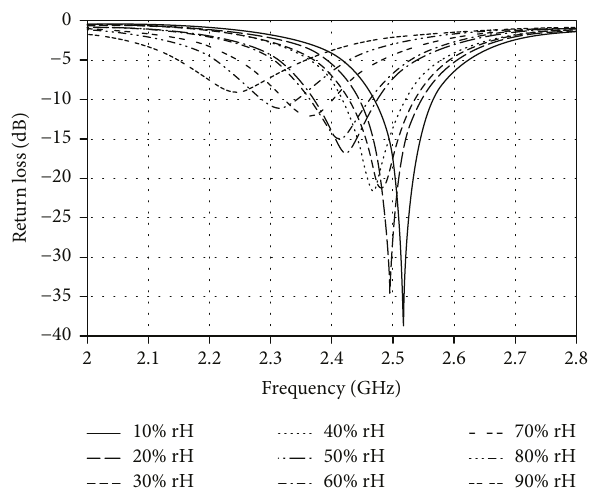
Figure 12: The e ff ect of relative humidity on return loss